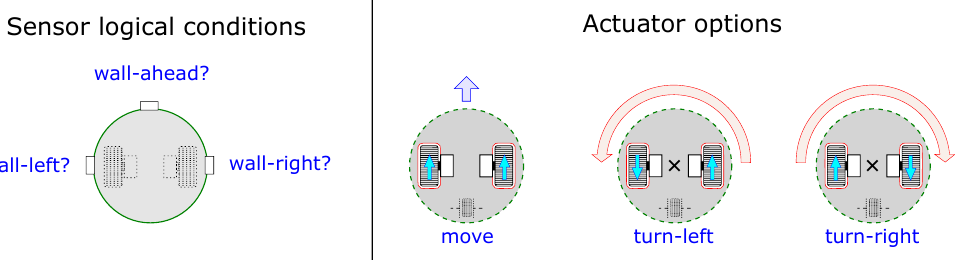
Figure 1. Schematic diagram of a navigation robot with two independently driven wheels and one unpowered omnidirectional wheel in the rear. At the right it shows the three Boolean sensors and at the left the three choices for the